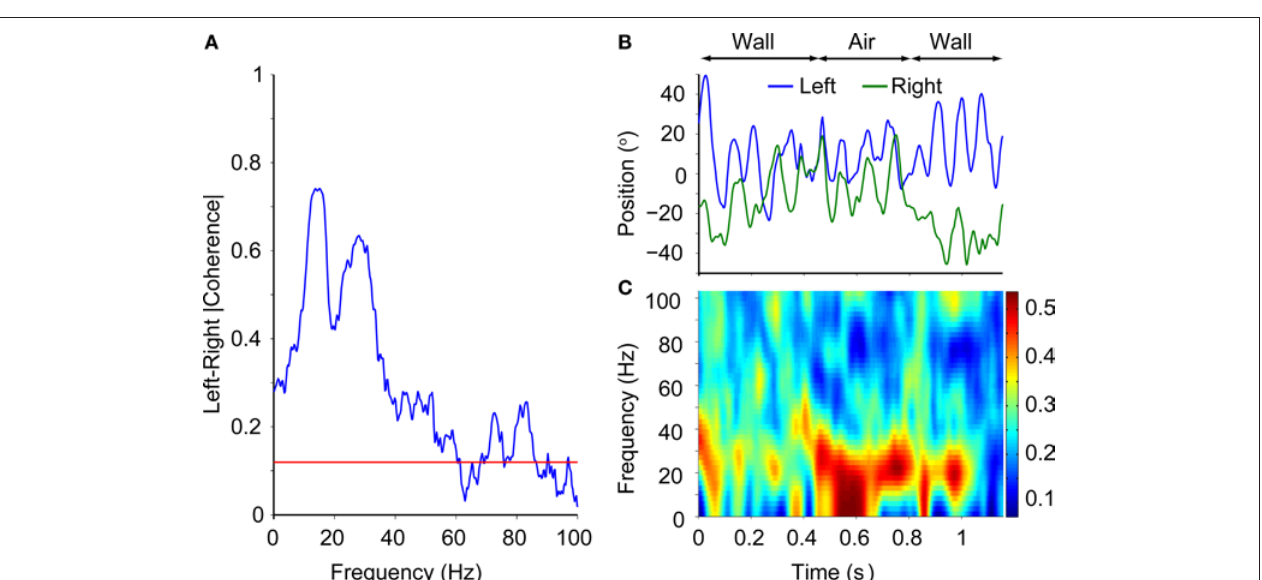
whiskers, then whisked in free air, then again contacted the wall with its right whiskers (denoted by arrows labeled “wall” and “air.” Video S5 in Supplementary Material is the video corresponding to this example.). (C) Coherence magnitude versus time for the same trial as in (B) . During wall contact, whisking coherence between the two sides of the face decreased. In (C) , coherence versus time was calculated by sliding a 167-ms long window along the whisker traces shown in (B) with a stepsize of 3.3 ms. The coherence color plot was smoothed with a two-dimensional Gaussian filter (SD = 5). For all whisker traces, the mean whisker angle was subtracted before calculating